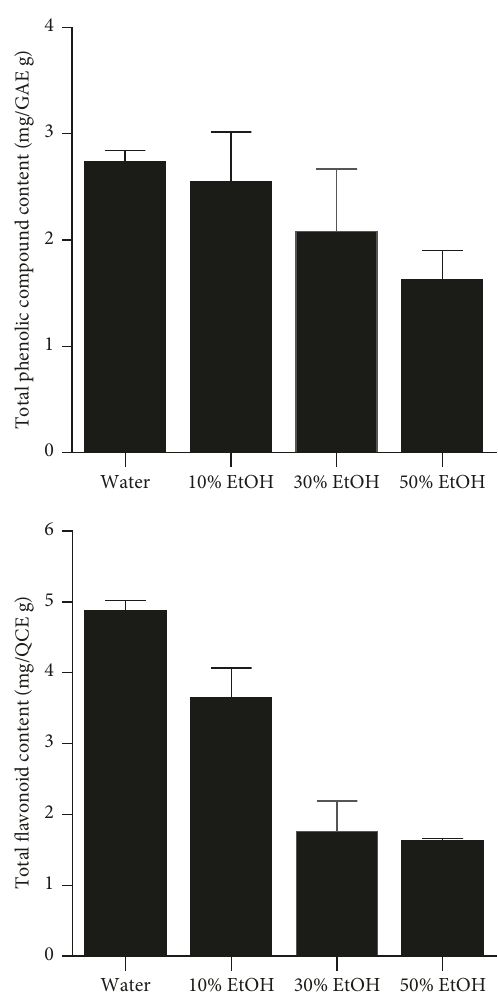
Figure 1: Total phenolic compound and flavonoid content of the